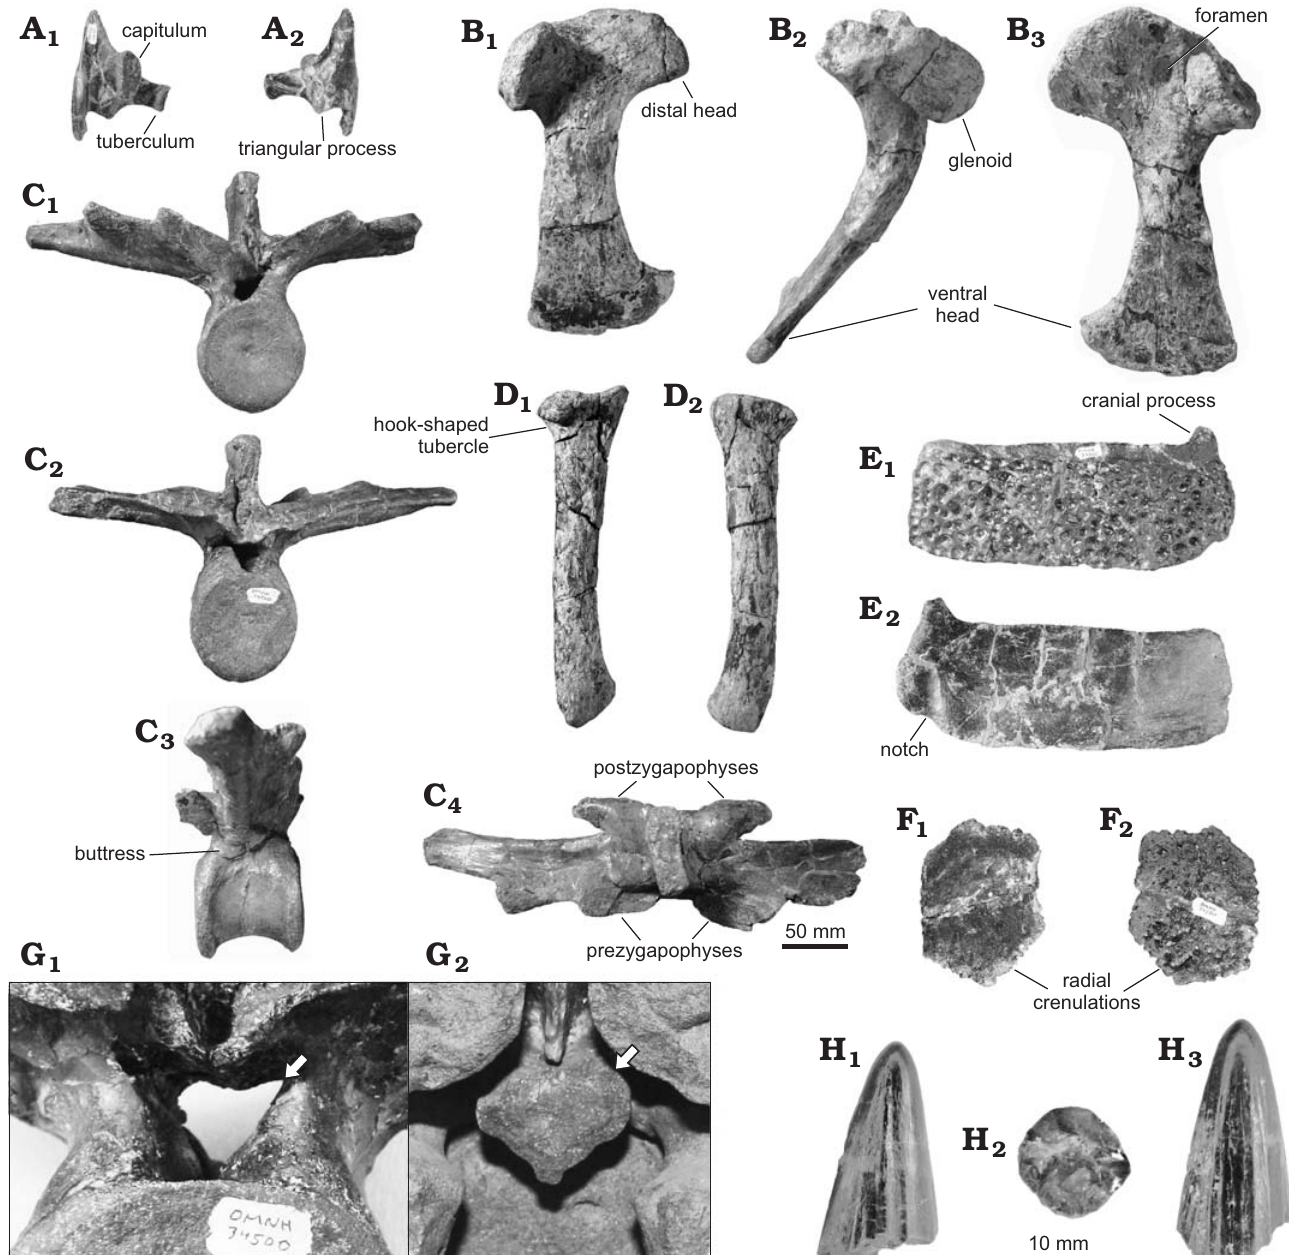
Fig. 2. Representative elements of goniopholidid crocodyliform Dakotasuchus kingi Mehl, 1941, OMNH 34500 from OMNH locality V828, Mussentuchit Member, Cedar Mountain Formation, Cenomanian. A . Right cervical rib in ventral (A 1 ) and dorsal (A 2 ) views. B . Right coracoid in lateral (B 1 ), caudal (B 2 ), and medial (B 3 ) views. C . Dorsal vertebra in cranial (C 1 ), caudal (C 2 ), lateral (C 3 ), and dorsal (C 4 ) views. D . Right radius in medial (D 1 ) and lateral (D 2 ) views. E . Dorsal scute in dorsal (E 1 ) and ventral (E 2 ) views. F . Ventral scute in dorsal (F 1 ) and ventral (F 2 ) views. G . Close-up views of neural canal in dorsal vertebrae, illustrating distinctive heart shape (white arrows); G 1 , OMNH 34500 vertebra in caudal view; G 2 , D. kingi holotype vertebra mold in cranial view. H . Tooth in labiolingual (H 1 ), basal (H 2 ), and mesiodistal (H 3 )